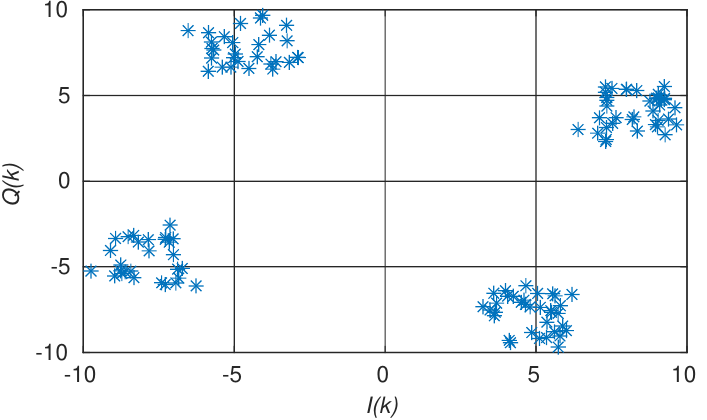
Figure 3. A constellation of integrated IQ signal of a received frame consisting of 128 symbols modulated with the speed of 2